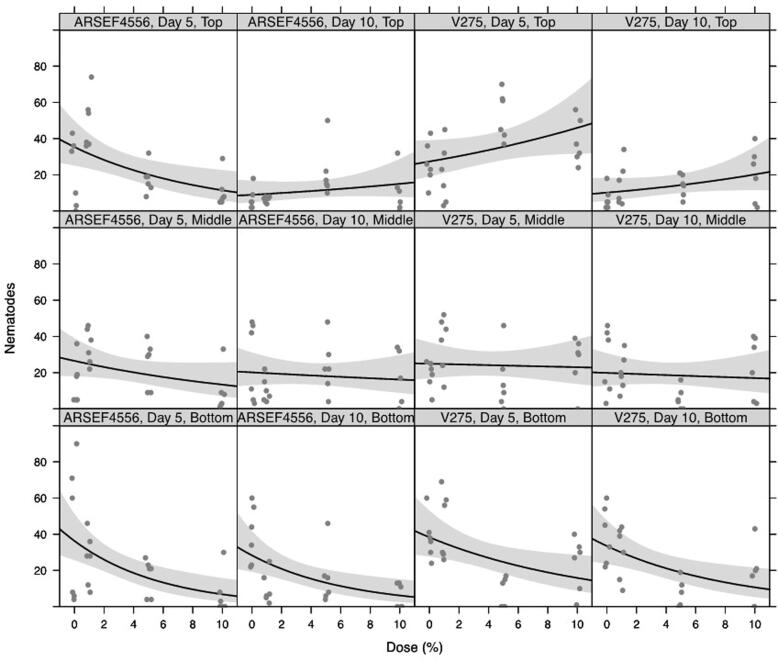
Dose-response curves for numbers of M. hapla retrieved following treatment with Me. brunneum, strain ARSEF4556 or V275. Doses ranged from zero (control) to 10% (w/w). Nematodes were recovered from ‘Top’, ‘Middle’, and ‘Bottom’ sections of experimental tubes, 5 and 10 days, post treatment. Fitted lines show log-linear responses. Shaded ribbons show 95% confidence envelopes. A small amount of horizontal ‘jitter’ was applied to visually separate overlapping data points.